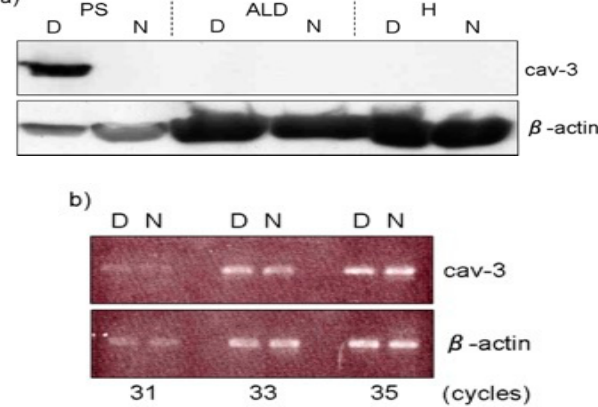
Figure 6. Expression of caveolin-3 (Cav-3) at protein and mRNA level. ( a ) Expression of Cav-3 in M. pectoralis superficialis (PS), M. anterior latissimus dorsi (ALD) and heart (H) was analyzed by Western blotting. Note that PS expressed higher amount of Cav-3 protein (7.12 ± 3.31-fold) in dystrophic chickens (D), while the expression in ALD and H was undetectable as in normal chickens (N). ( b ) The semi-quantitative RT-PCR analysis indicated that its mRNA expression was at the similar level between dystrophic (D) and normal (N) pectoralis muscle. Adopted from Matsumoto et al. 2010